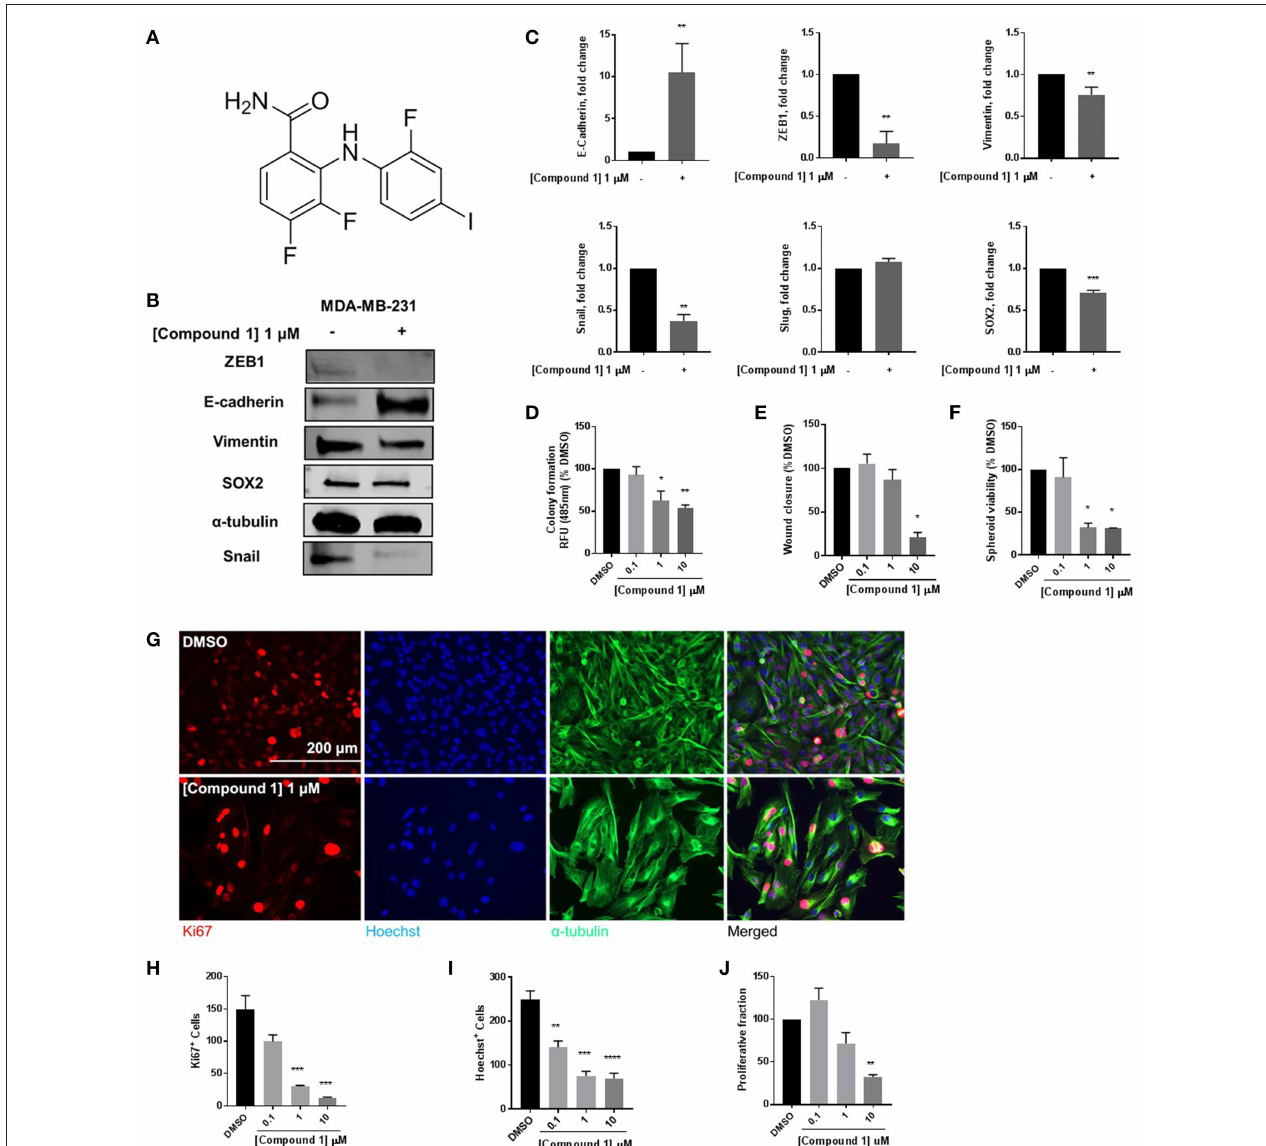
FIGURE 1 | Compound 1 induces MET and decreases colony formation, cell migration, and spheroid formation in MDA-MB-231 cells. (A) Structure of compound 1 . (B) Western blot of epithelial marker E-cadherin, mesenchymal markers Vimentin, Snail, and ZEB1, and stemness marker SOX2 in MDA-MB-231 cells. (C) Quantification of protein expression of E-cadherin, ZEB1, vimentin, Snail, Slug, and SOX2. Data represent ± SEM ** p < 0.01; *** p < 0.001; vs. DMSO control group determined by two-tailed Student’s t -test. (D) Compound 1 inhibited MDA-MB-231 colony formation after 14 days of treatment in a concentration-dependent manner. Data represent ± SEM of experiments run in triplicate, * p < 0.05; ** p < 0.01 vs. DMSO control group determined by one-way ANOVA with the Bonferroni post hoc test. (E) Wound closure was measured as a percentage of untreated DMSO control group (missing compound 1 at various conc here). * p < 0.05 vs. DMSO control group determined by one-way ANOVA with the Bonferroni post hoc test (MDA-MB-231 cells). (F) Quantification of the spheroid viability in MDA-MB-231 cells, values indicate ± SEM of three experiments run in triplicate. * p < 0.05 vs. control group determined by one-way ANOVA with the Bonferroni post hoc test in MDA-MB-231 cells. (G) Immunofluorescence staining of Ki67, Hoechst, and α -tubulin in MDA-MB-231 cells treated with DMSO or compound 1 (1 µ M), for 72h, scale bar 200 µ m. (H) Ki67 + cells decreased with increasing concentrations of compound 1 . (I) Decrease in Hoechst + cells with increasing concentrations (0.1, 1, 10 µ M) of compound 1 . (J) The proliferative fraction calculated as the ratio of Ki67 + cells to Hoechst + cells at increasing concentration. Data represent ± SEM of three different experiments. ** p < 0.01; *** p < 0.001 vs. control group determined by one-way ANOVA with the Bonferroni post hoc